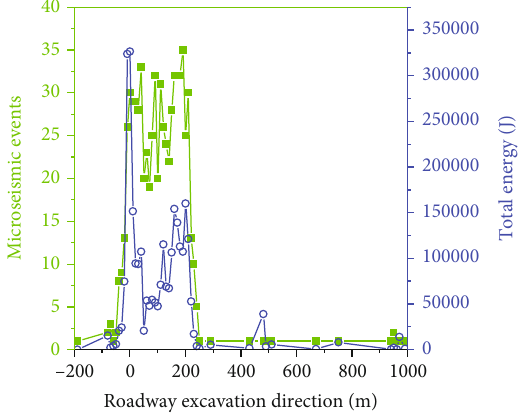
Figure 10: The distribution of the number of microseismic events and total energy along roadway excavation